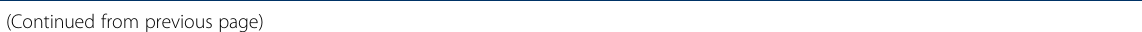
Protocol Registration: Protocol registration number: